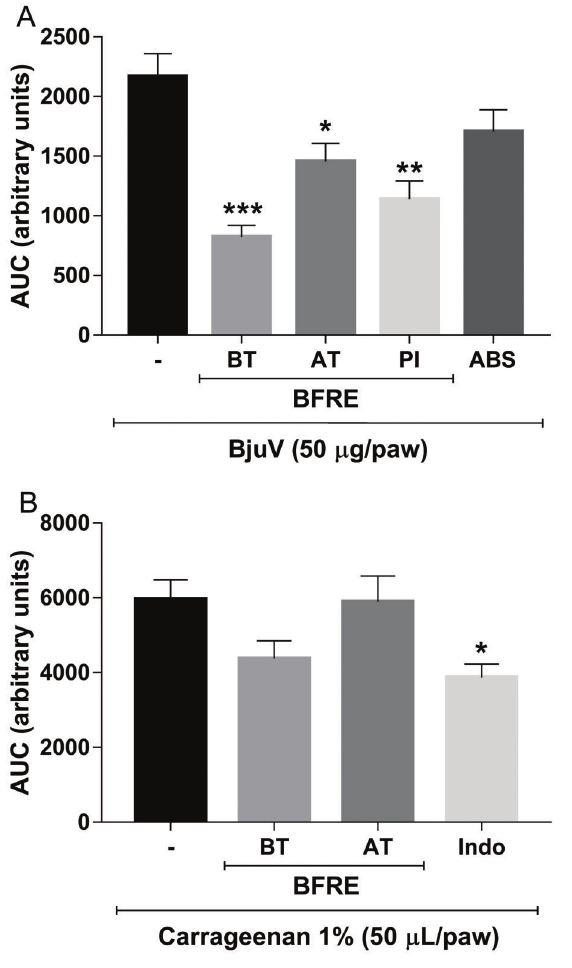
Figure 3. Effect of Bredemeyera fl oribunda root extract (BFRE) on Bothrops jararacussu venom (BjuV)-induced ( A ), and carra- geenan-induced ( B ) paw edema. Paw volume was measured at 10, 30, 60, 120, 240, and 480 min after BjuV inoculation and total edema was calculated as AUC (area under curve). Data are reported as means ± SE. *P o 0.05, **P o 0.01, and ***P o 0.001 compared to BjuV/carrageenan (control) (ANOVA with a Bonfer- roni post-test). BT: group treated with BFRE (150 mg/kg, ip ) 30 min before BjuV/carrageenan inoculation; AT: group treated with BFRE (150 mg/kg, ip ) 30 min after BjuV/carrageenan inoculation; PI: BjuV and BFRE (1:3) preincubated for 15 min at 37°C before inoculation; ABS: antibothropic serum; Indo: indo- methacin (10 mg/kg, ip ) 30 min before carrageenan